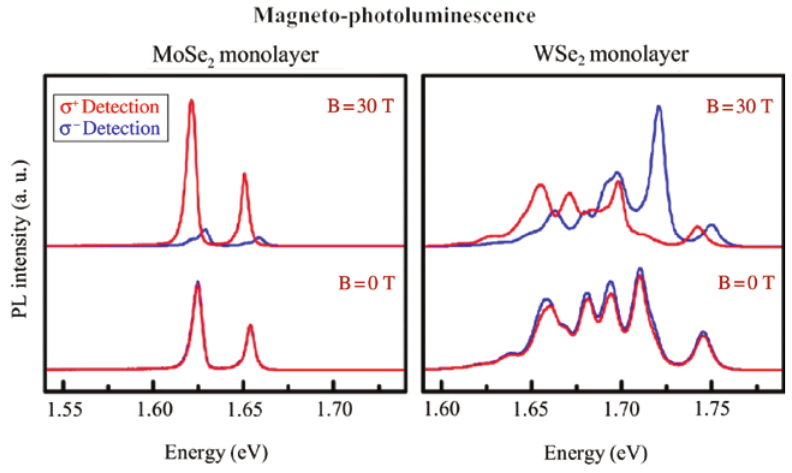
and WSe monolayers illustrat- 2 2